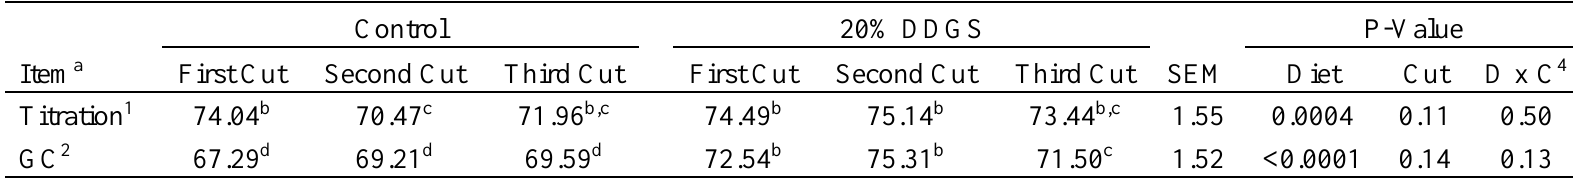
Table 7. Least squares means for iodine values of jowl fat determined by two different methods of